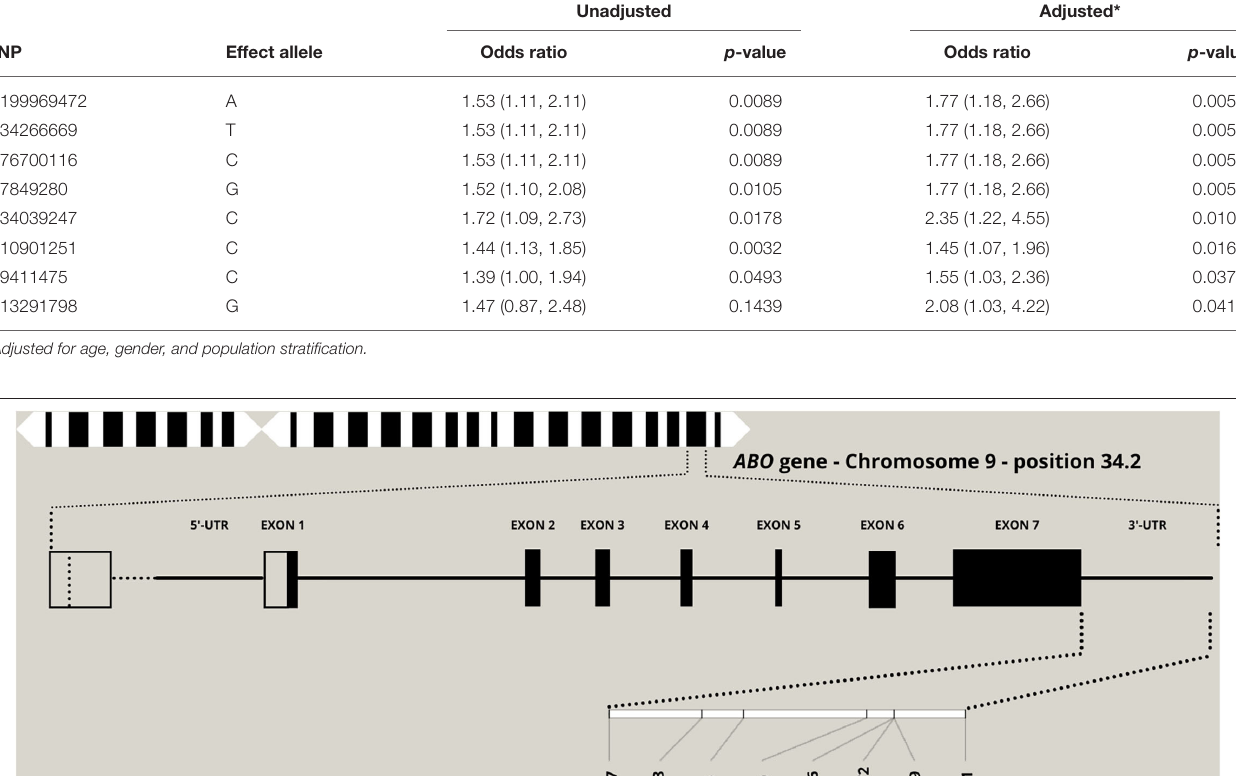
TABLE 3 | Unadjusted and adjusted effect size and p -value of the eight significant single nucleotide polymorphisms (SNPs) in chromosome 9 on the ABO gene. Unadjusted